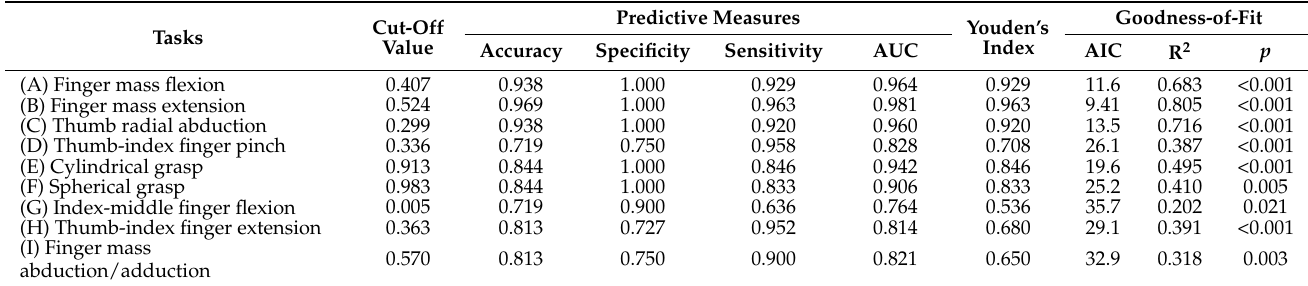
Predictive Measures